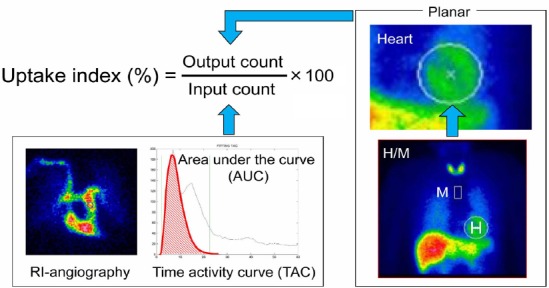
Region of interest (ROI) settingsInput counts: Typical time-activity curves (TACs) from the pulmonary arteryThe first peak of the TAC is fitted with a gamma function, and the area under the count-time activity curve (AUC) is obtained by integrating the gamma functionsOutput counts: Heart counts from the conventional heart-to-mediastinum ratios